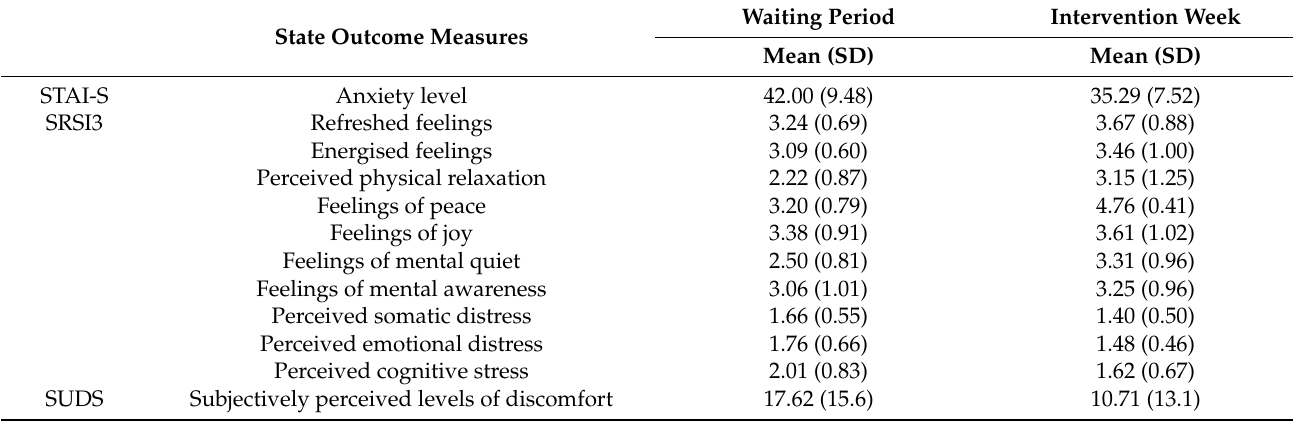
Table 3. Descriptive statistics for the state measures collected each day during the waiting week (7 days before the start of the intervention) and during the intervention phase, after each treatment module. Data are provided in means and standard deviation (SD). State–Trait Anxiety Inventory-State: STAI-S; Smith Relaxation State Inventory 3: SRSI3; Subjective Units of Distress Scale: